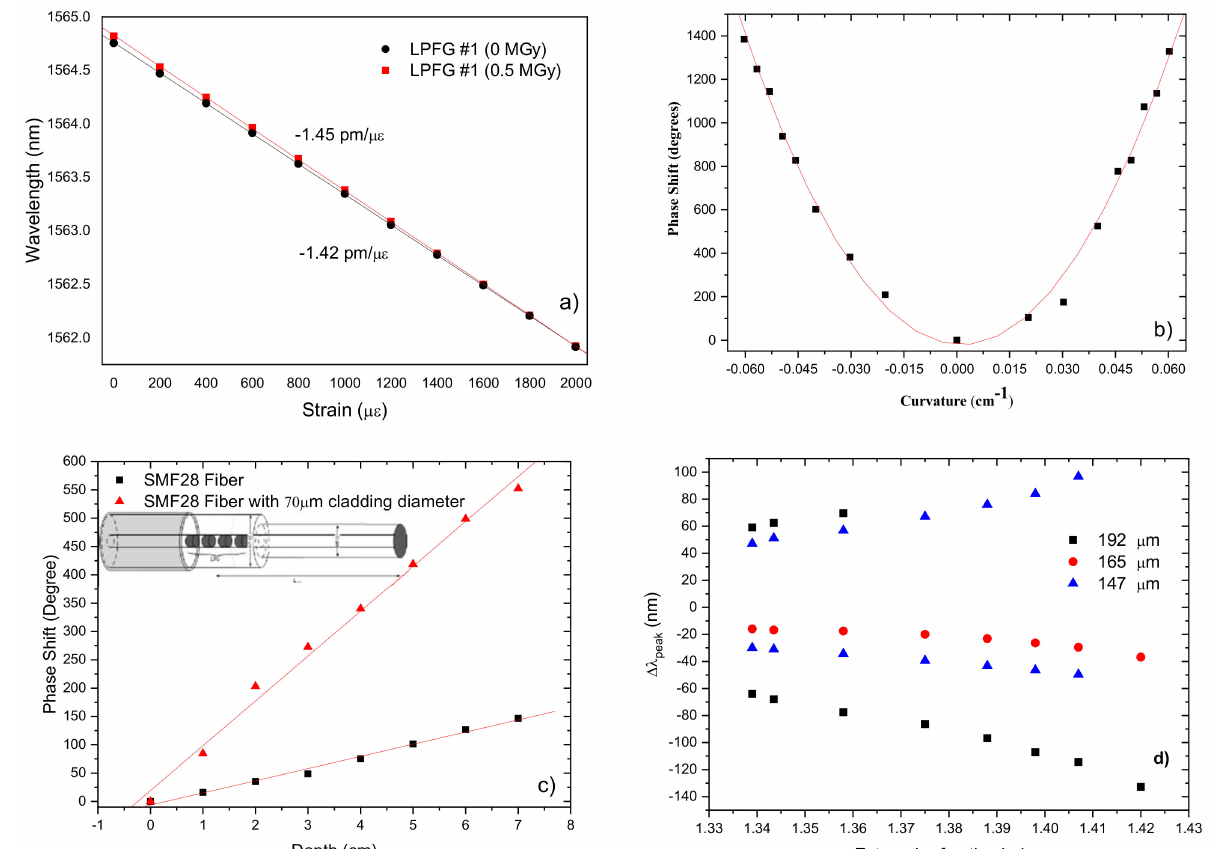
Figure 14. Characterization of LPFGs sensitivity to ( a ) Strain. Adapted with permission from [94] © 2021 The Optical Society; ( b ) bending. Reprinted with permission from [125]. © 2021 The Optical Society; ( c ) liquid level. Adapted with permission from [126] © 2021 SPIE; and ( d ) surrounding refractive index. Reprinted with permission from [127] © 2021